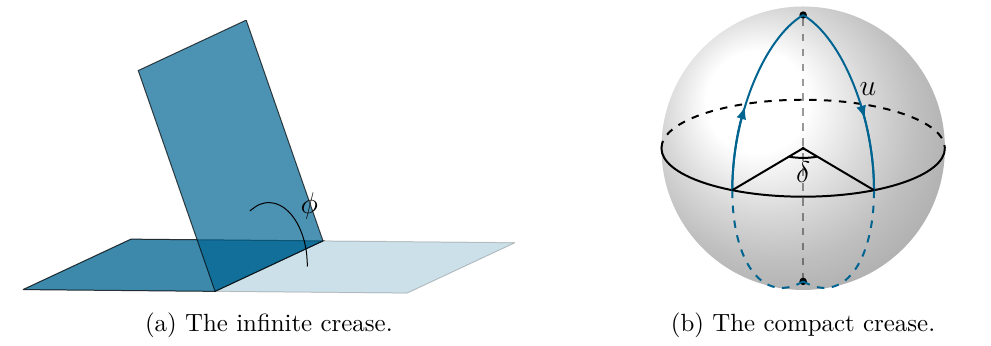
Figure 1 . On the left, the infinite crease with φ = 2 π/ 3 . On the right, a representation of the same crease after a conformal transformation. Each of the half planes is mapped to a hemisphere, here represented by the two arcs on S 2 (since we cannot draw S 3 ). Each point along the arc represents a circle, which shrinks at the equator ( z = 0 in the image) and is of maximal radius 1 at the north pole, where it is also glued to the second